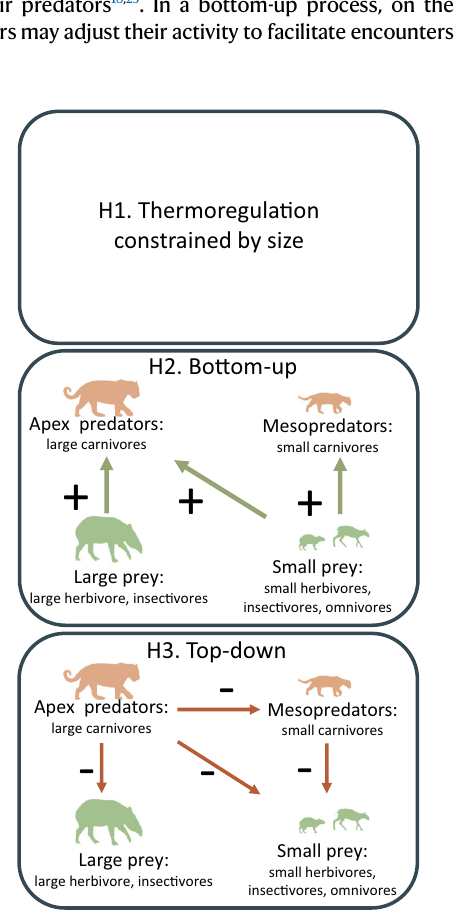
insectivores) will avoid top-predators (3). “ + ” represents a positive relation- ship between the activity of species groups (bottom-up process), and “ − ” represent a negative relationship between the activity of species groups (top- down process). Silhouettes from phylopic.org: jaguar, ocelot, and agouti by Gabriela Palomo-Munoz; tapir no license; browsing ruminant by Nobu Tamura (vectorized by T. Michael Keesey) http://creativecommons.org/